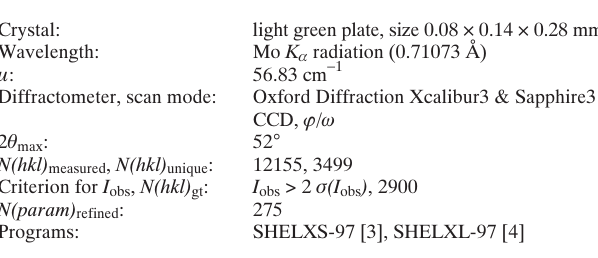
Table 1. Datacollection and